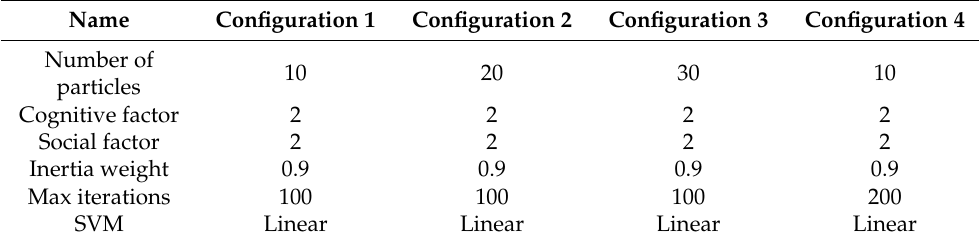
Table 15. Initial parameters used for the PSO for experiments with linear kernel.